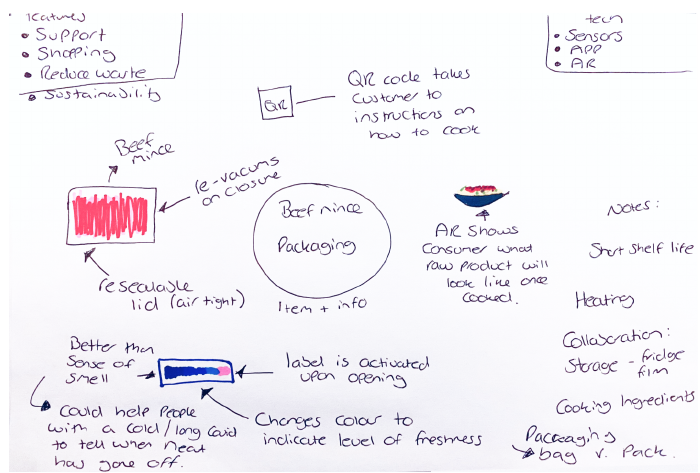
Figure 5. Design by P23 of a “resealable minced beef